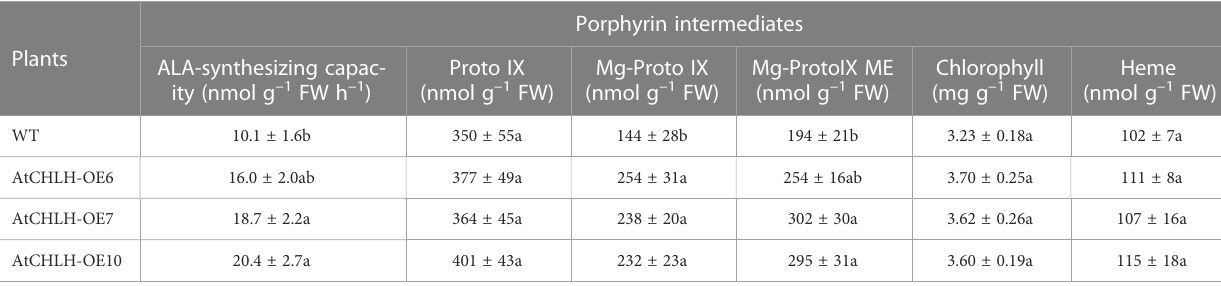
TABLE 1 Levels of metabolic intermediates in the porphyrin biosynthetic pathway in leaves of WT and AtCHLH -expressing transgenic rice plants grown under optimal conditions.